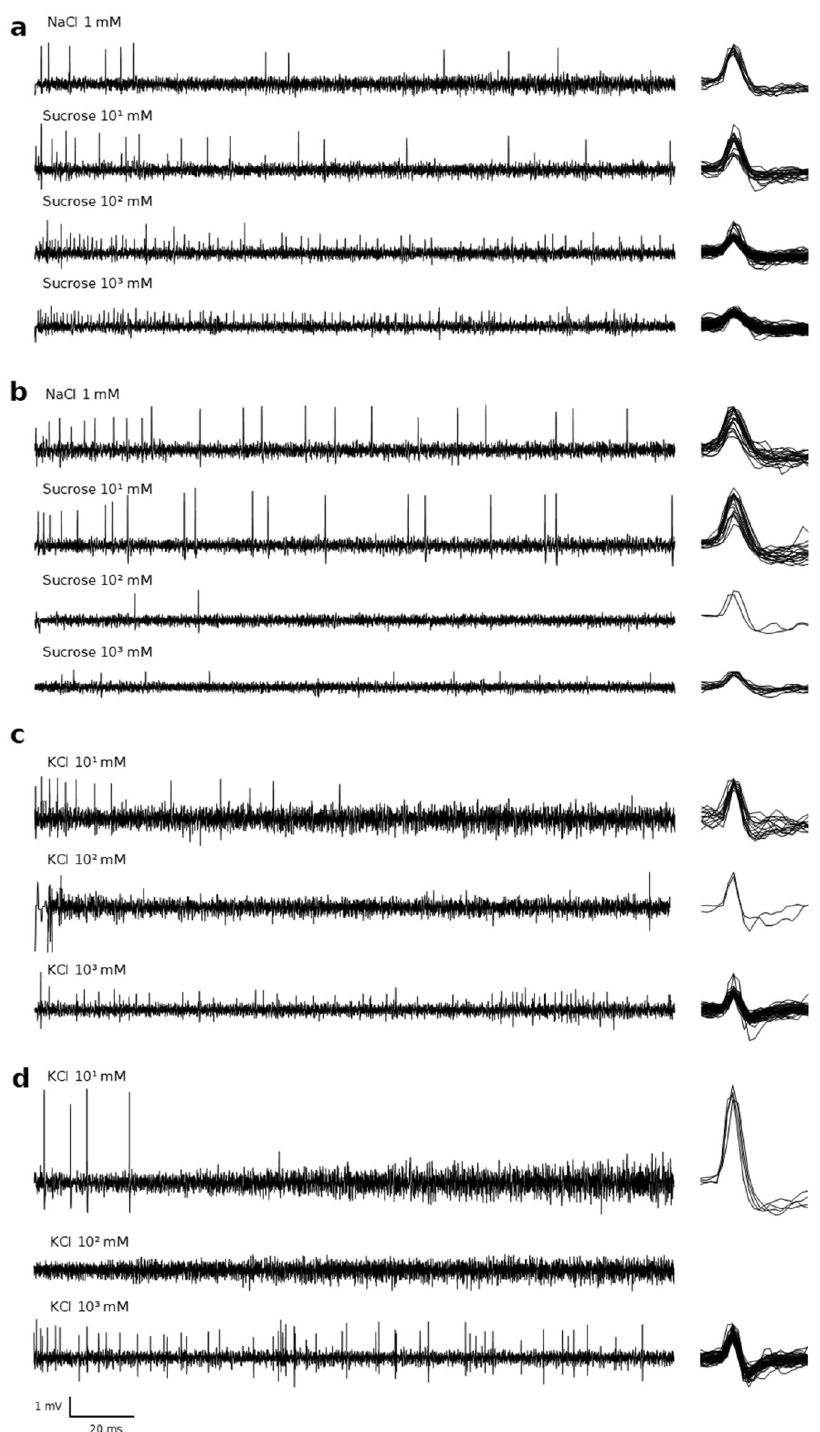
Figure 2. Representative single-sensillum recording traces (left) of sensilla chaetica and superimposed spikes (right) detected in the recording (6 ms section). Each group ( a – d ) shows the response of the same sensillum to increasing concentrations of test stimulus. ( a ) Labial palp of C. pomonella female, ( b ) antenna of C. pomonella male, ( c ) labial palp of C. pomonella female, and ( d ) antenna of L. botrana male. NaCl